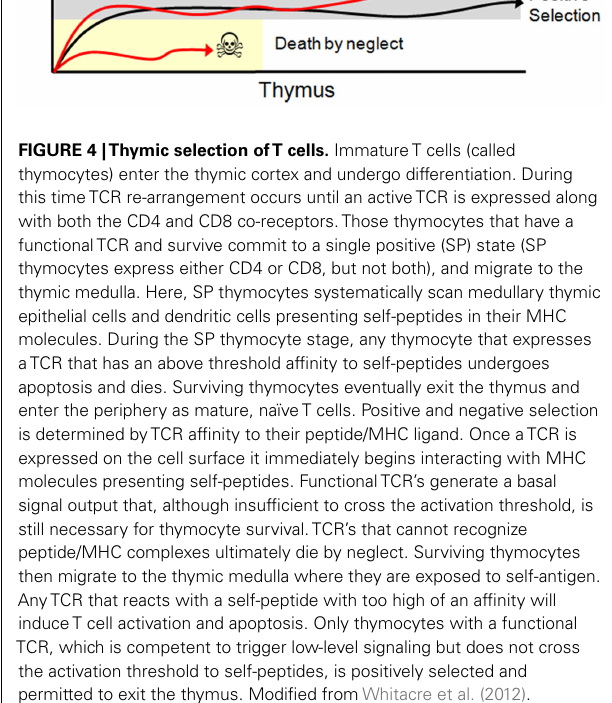
mediate chromosome segregation toward spindle poles.